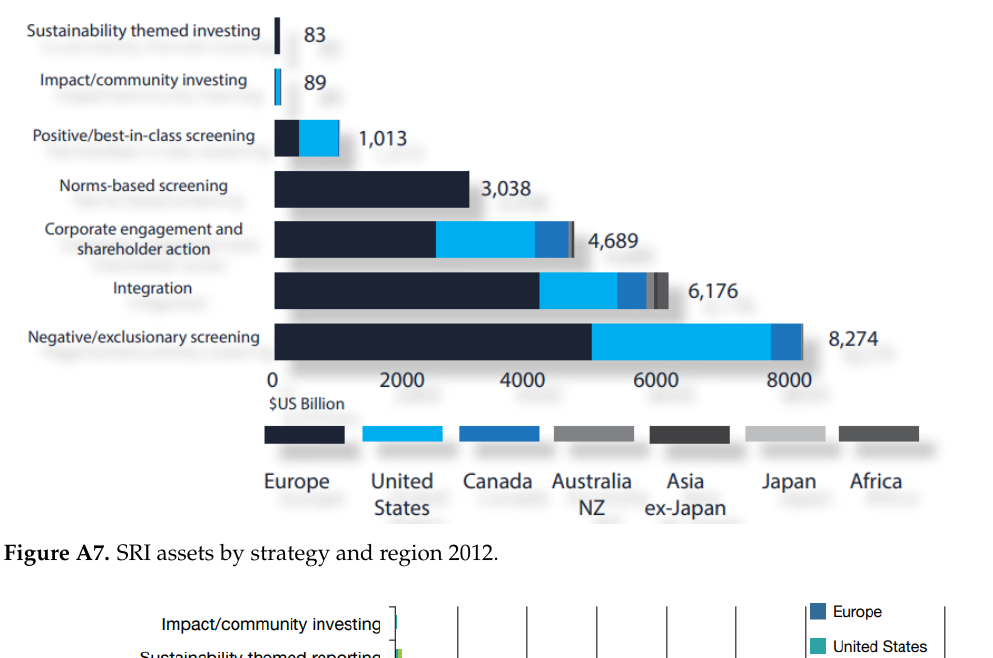
Figure A6. Global growth of sustainable investing strategies 2012–2020.